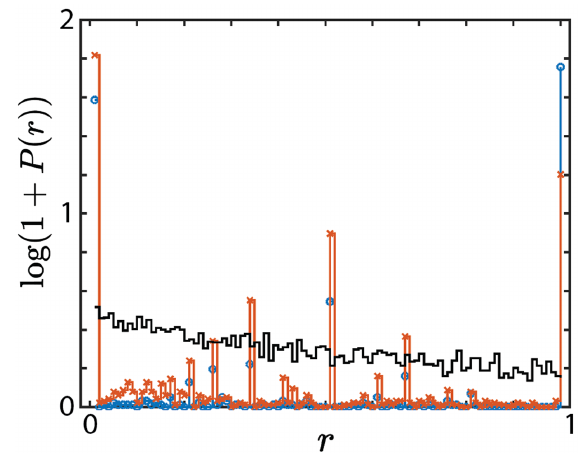
FIG. 9. The level statistics of the experimental sequences and the exact Haldane-Shastry Hamiltonian. The distribution of level-spacing parameter r (see text) for the exact Haldane- Shastry Hamiltonian (blue circles), the experimentally real- ized Hamiltonian (red crosses), and the modified sequence [Eq. (A18)] (black lines). All results are computed using exact diagonalization for a 12-ion system. While the modified sequence shows a relatively generic structure, both the experi- mental approximation to the Haldane-Shastry Hamiltonian and the exact Haldane-Shastry share a similar highly nongeneric and highly degenerate